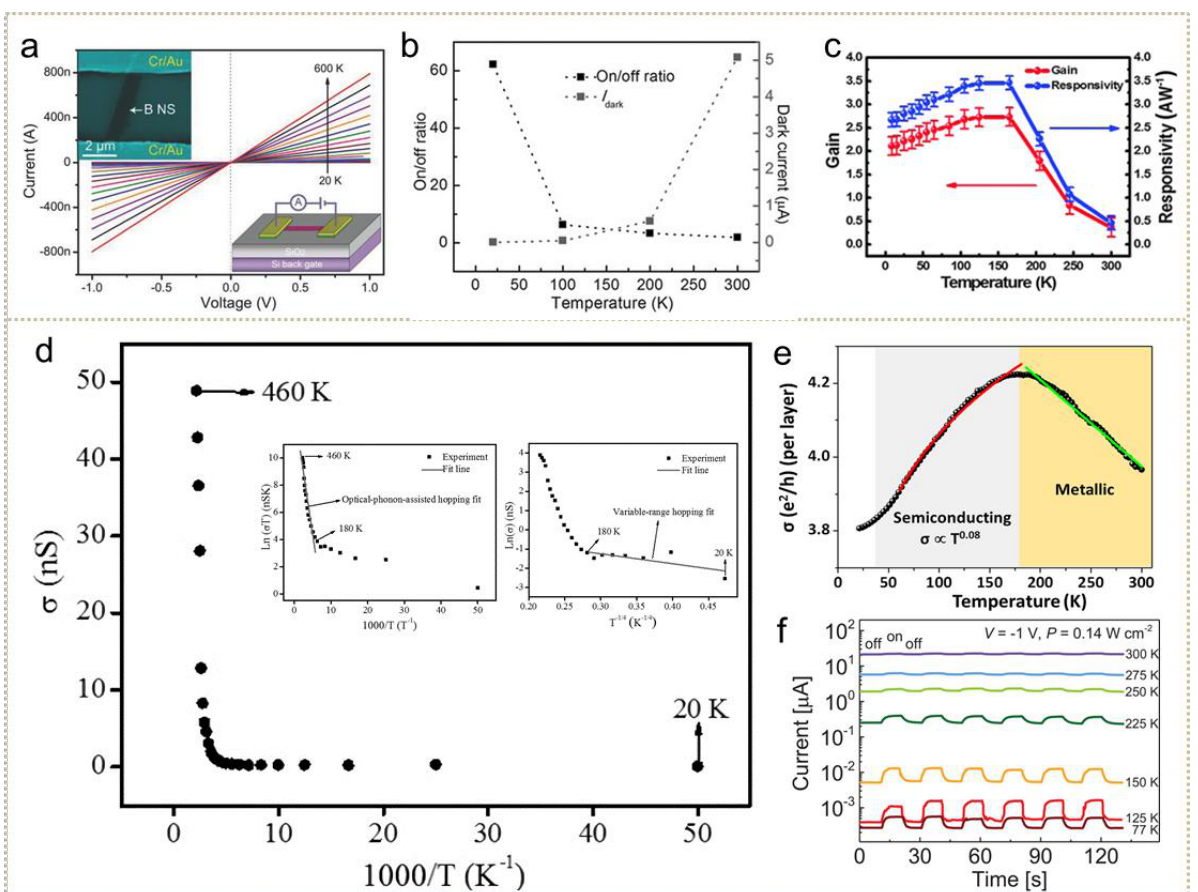
Figure 4. Cooling-enhanced phenomena on photoconductive photodetectors. ( a ) Temperature-dependent J-V characteristics of ultrathin boron nanosheets (adapted from [87], with permission from Wiley-VCH, 2015). ( b ) Temperature-dependent on/off ratio and dark current in Ta 2 NiSe 5 nanoflakes (adapted from [129], with permission from Wiley-VCH, 2016). ( c ) Temperature-dependent gain and responsivity in Sb 2 Te 3 photodetectors (adapted from [128], with permission from the Royal Society of Chemistry, 2015). ( d ) Schematic of photoconductivity variation with temperature (adapted from [130], with permission from Wiley-VCH, 2017). ( e ) Photoconductivity of graphene (adapted from [74], with permission from the American Chemical Society, 2020). ( f ) Current variation under cycled light at different temperatures (adapted from [20], with permission from Wiley-VCH, 2017).